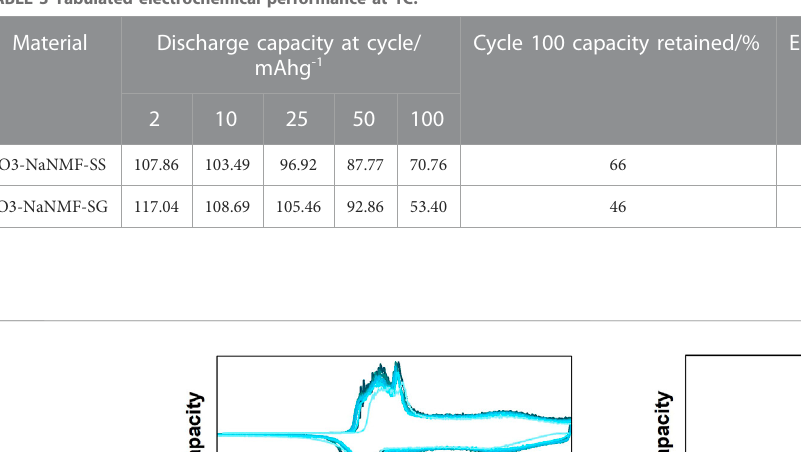
TABLE 3 Tabulated electrochemical performance at